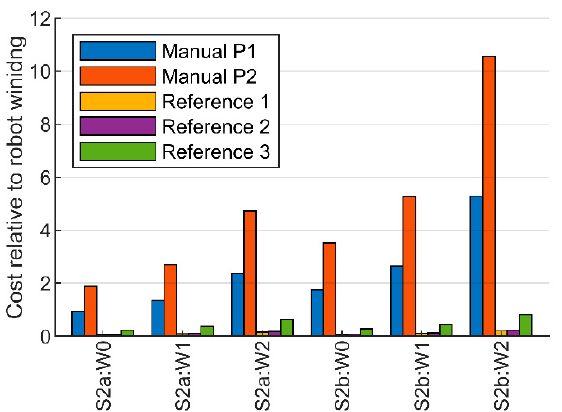
Figure 13. Estimated assembly costs for manual stator cable winding and conventional automated stator winding references scenarios from [4] relative to robotized stator cable winding of S2a–b in winding development scenarios W0–2, for P1–2 with manual winding and for P1 with conventional automation. References 1–2 are highly automated high throughput insert winding and hairpin winding, and Reference 3 is simpler lower throughput insert